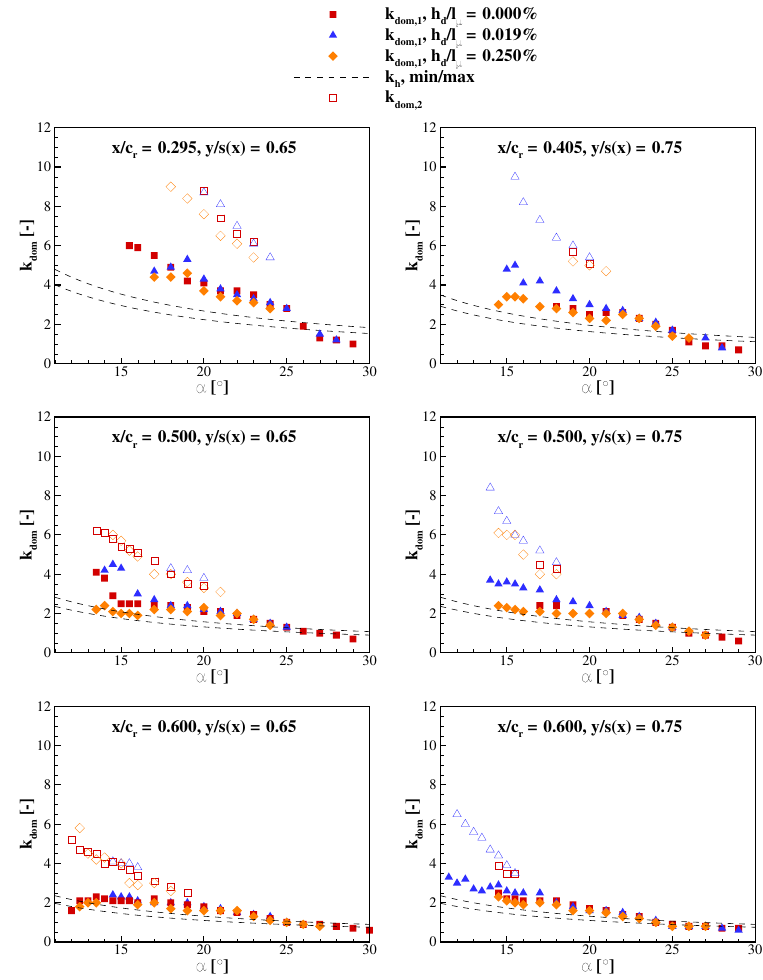
Figure 16. Dominant peaks (first peak with full symbols, second one with empty symbols) measured at six sensor locations as function of angle of attack for three cases: free transition case h d / l µ = 0.000% (red squares), case with trip dots h d / l µ = 0.019% (blue triangles) and overtripped case h d / l µ = 0.250% (orange diamonds). Dashed curves follow the maximum and minimum empirical helical mode frequency typical for slender delta wings